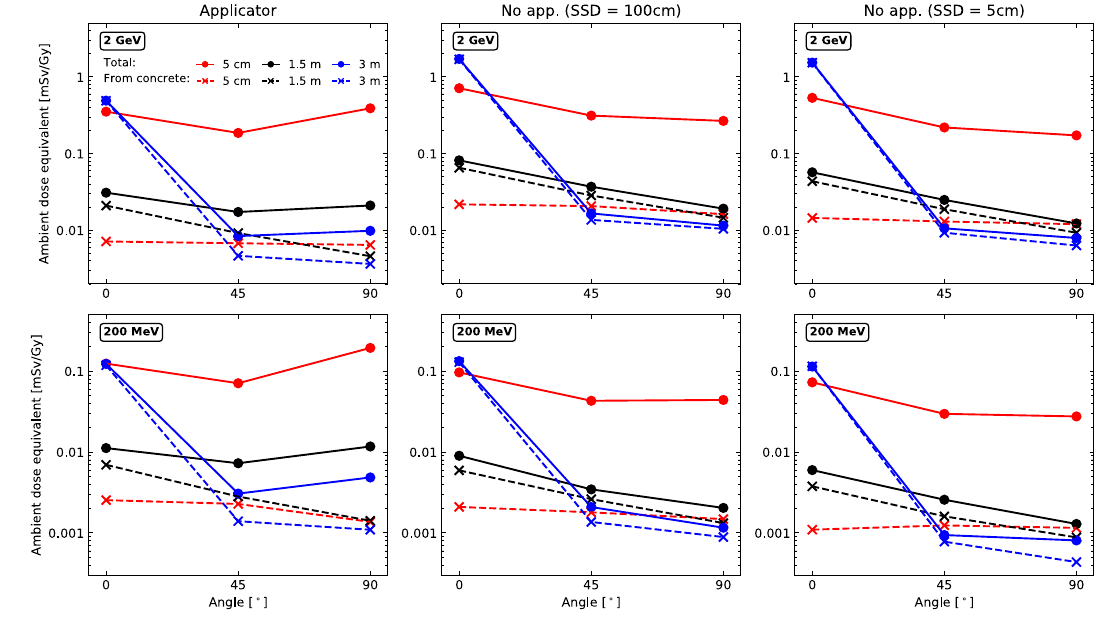
Figure 6. Ambient neutron dose equivalent per treatment gray at 5 cm, 1.5 m, and 3 m from the water ◦ ◦ ◦ phantom, for angles of 0 , 45 , and 90 from the central beam axis, and for all simulation configurations. Upper row: 2 GeV primaries. Bottom row: 200 MeV primaries. Each column represents a specific configuration, and each colour represents a distance from the water phantom. Solid lines with circular markers are the total dose equivalent values, while dashed lines with cross markers are dose equivalent values based on the fluence of neutrons coming from the